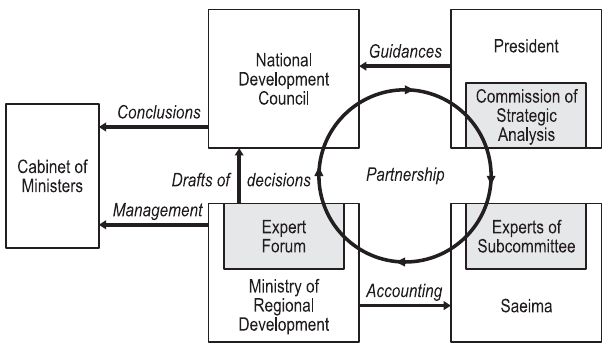
Fig. 2. Development planning system: partnership